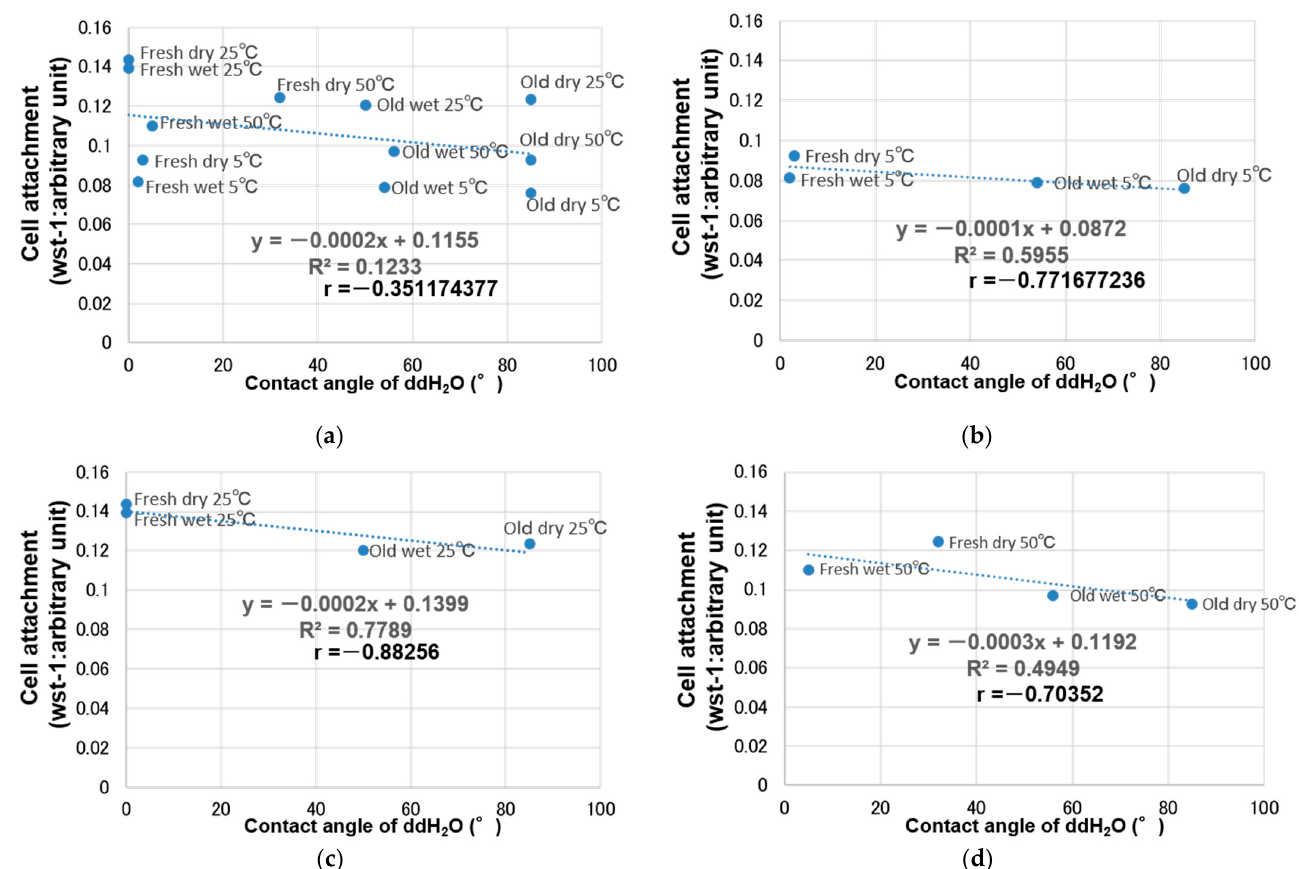
Figure 5. Regression analysis of titanium temperature and cell attachment using a quadratic curve ( R 2 = 0.81).